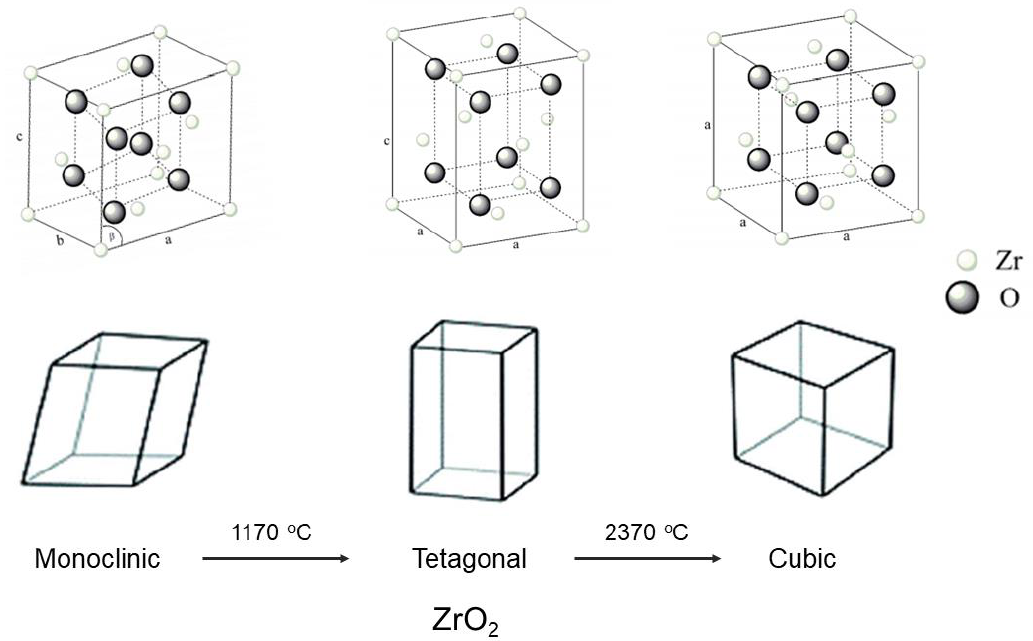
Figure 5. Structure of zirconia (monoclinic, tetragonal, and cubic). Modified from [32].